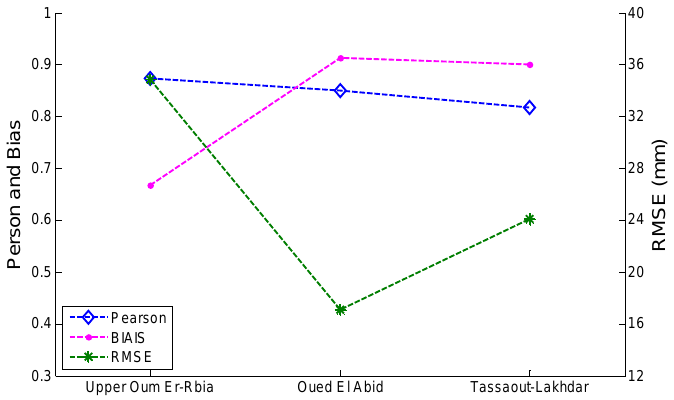
Figure 11. Evaluation statistics for the three studied sub watershed at monthly time scale.